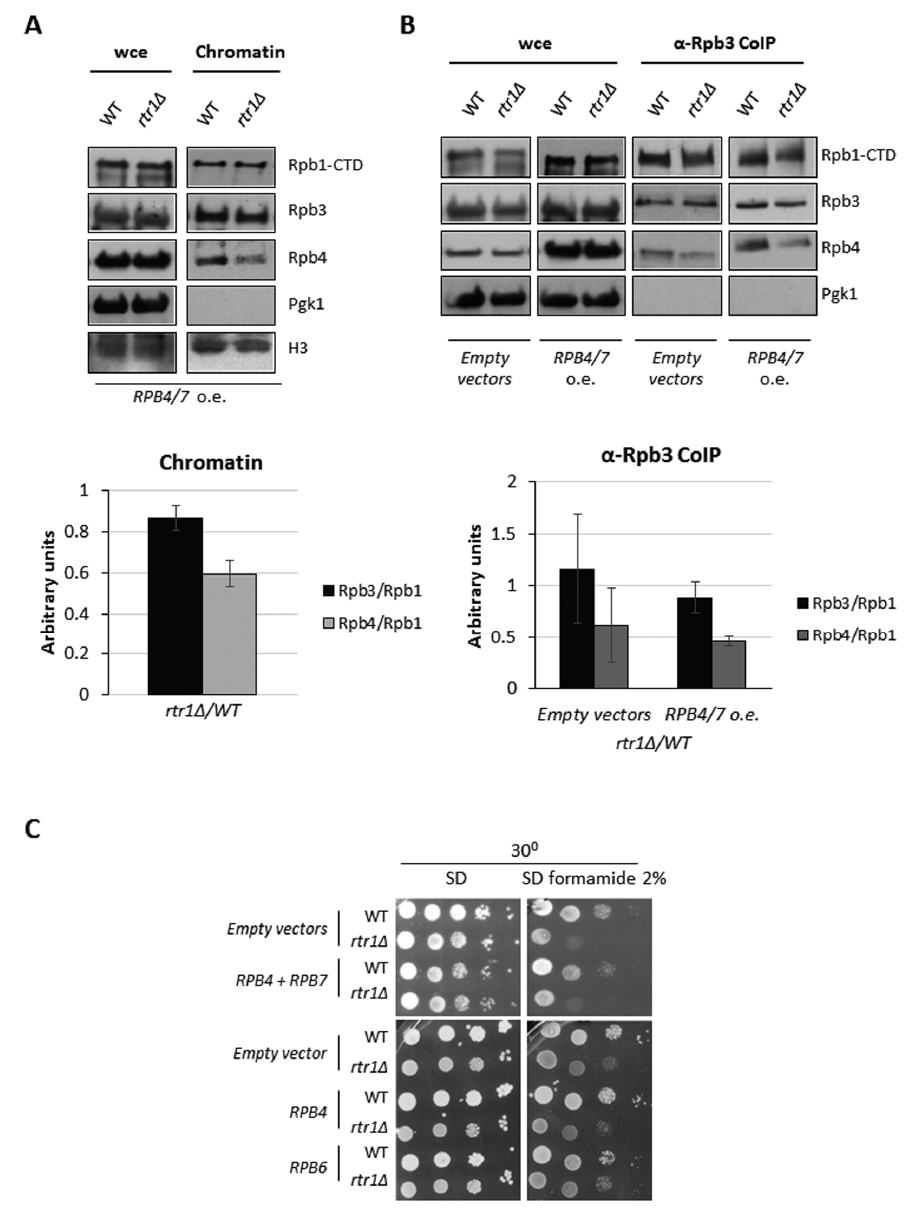
Figure 6. RPB4/7 overexpression does not overcome RNA pol II assembly defect in rtr1 ∆ mutant. ( A ) whole-cell extract and chromatin enriched fractions obtained by yChEFs procedure [63,64] from wild-type and rtr1 ∆ cells overexpressing RPB4/7 genes from high copy number plasmids, grown in SD medium at 30 ◦ C. Proteins were analyzed by Western blot with specific antibodies against Rpb1, Rpb3, and Rpb4. H3 histone was used as a positive control of chromatin-associated protein and Pgk1 employed as a negative control of cytoplasmic contamination. Lower panel: quantification for each RNA pol II subunit vs. Rpb1. Median and standard deviation of two independent biological replicates. ( B ) Rpb3 immunoprecipitation in wild-type and rtr1 ∆ cells both overexpressing RPB4/7 genes from high copy number plasmids or harboring corresponding empty vectors, grown in SD medium at 30 ◦ C. Western blots of Rpb1, Rpb3, Rpb4, and Pgk1 from whole cell crude extracts and immunoprecipitated samples are shown (upper panel). Lower panel: quantification of Western blot showing rtr1 ∆ mutant/wild-type strains ratio for each subunit vs. Rpb1. Median and standard deviation of two independent biological replicates. ( C ) RPB4 + RPB7 , RPB4 and RPB6 overexpression in wild-type and rtr1 ∆ mutant cells grown in SD and SD supplemented with 2% formamide at 30 ◦